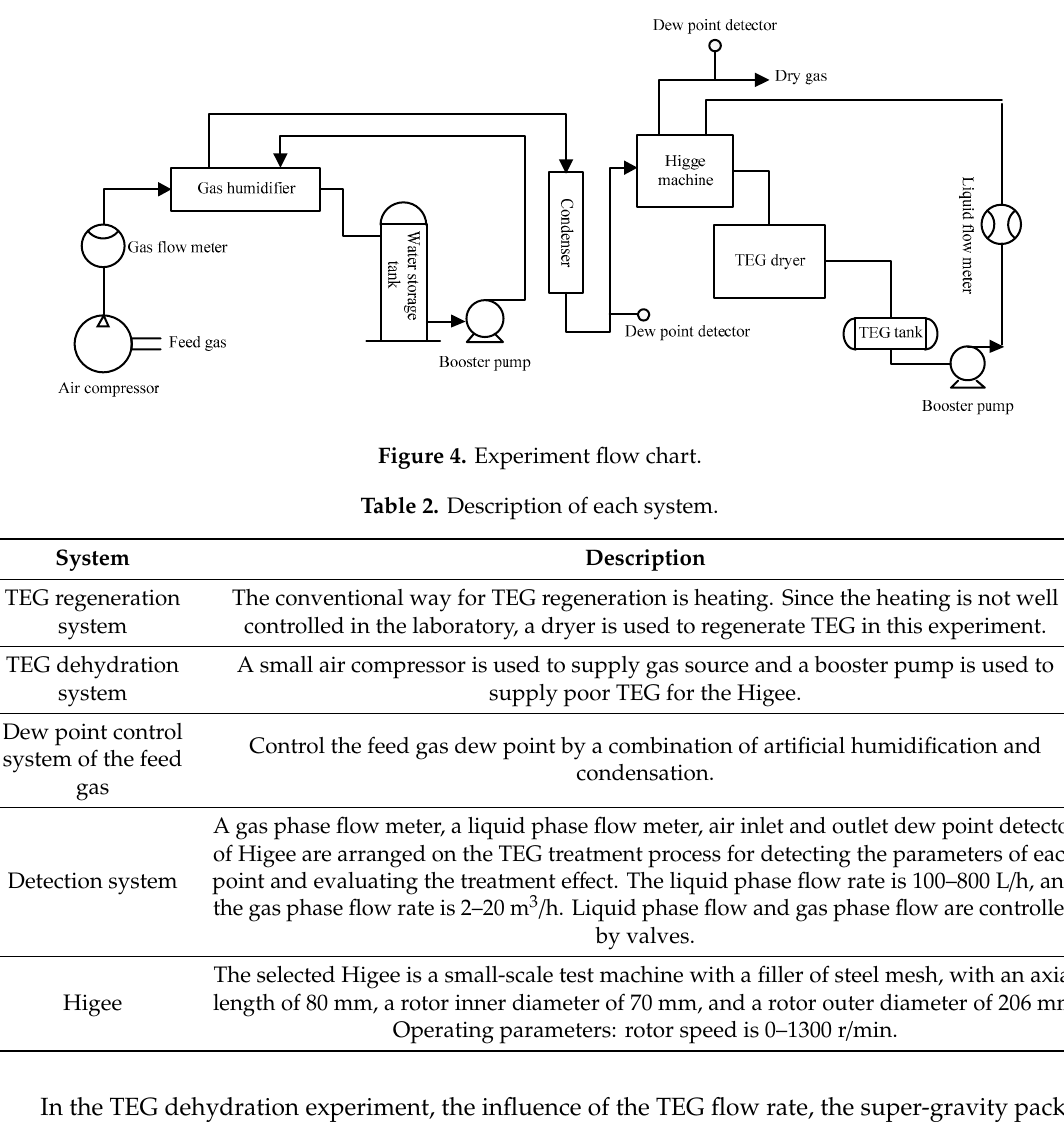
Table 3. Experimental conditions.